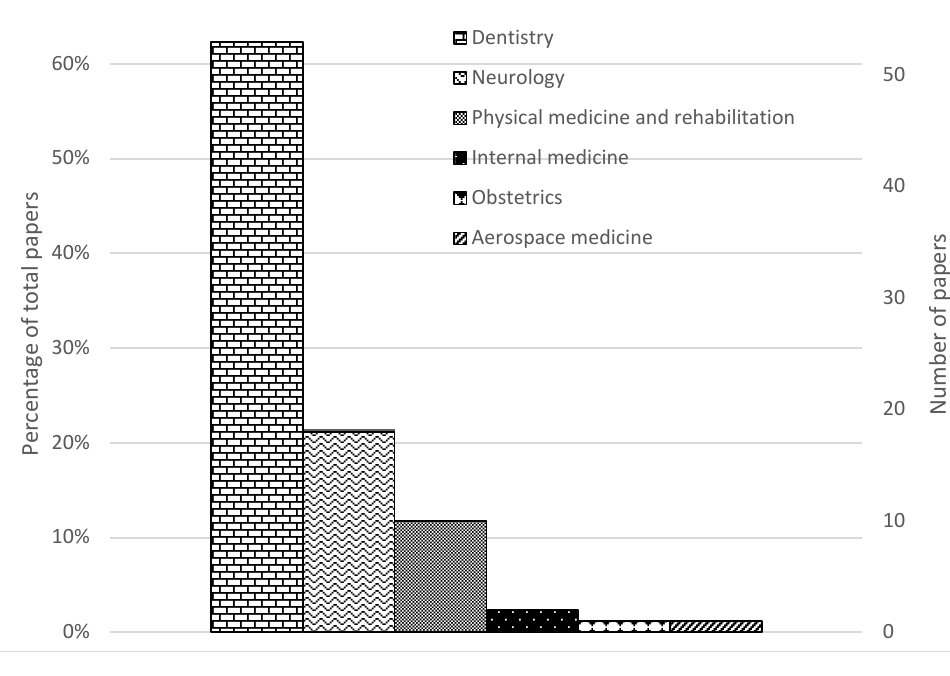
Figure 2. PRISMA flow diagram of search results.